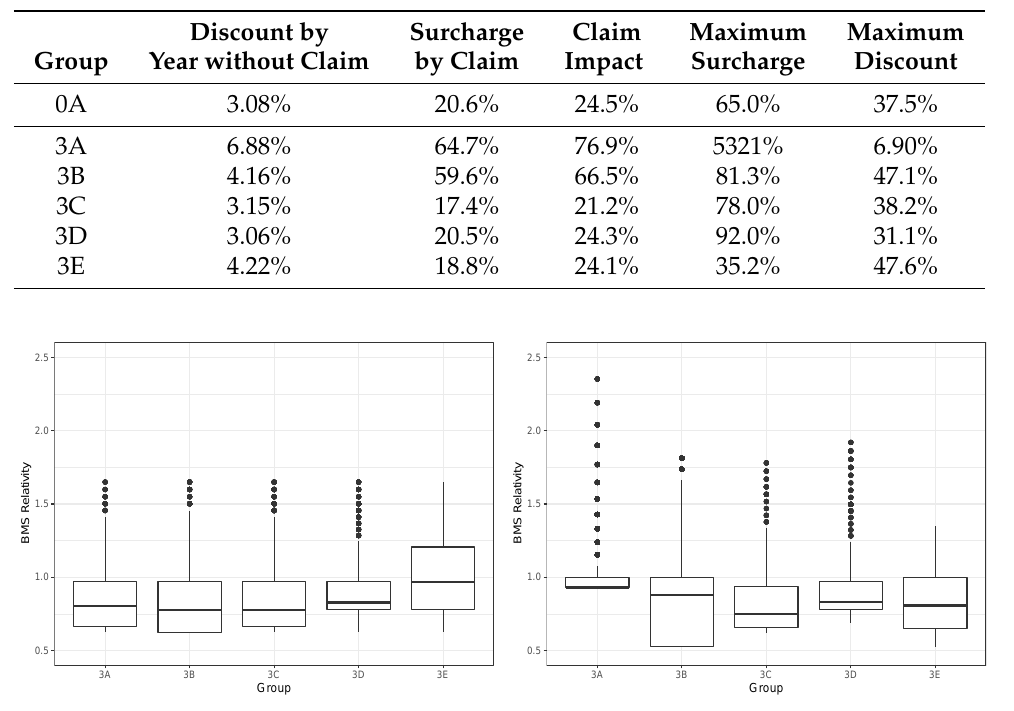
Table 6. Discounts and surcharges for each group.